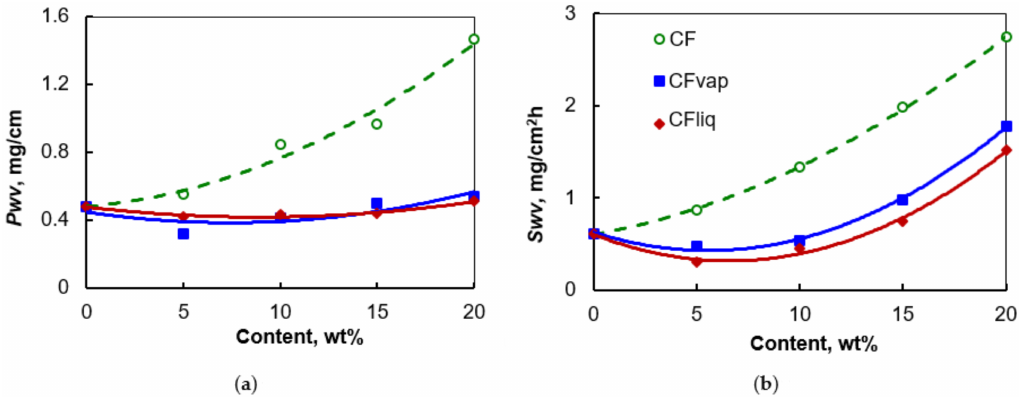
Figure 14. Dependence of PDMS / CF composite films’ water vapor permeability Pvw ( a ) and water vapor sorption Swv ( b ) upon CF content and treatment mode (treatment duration 6 h).